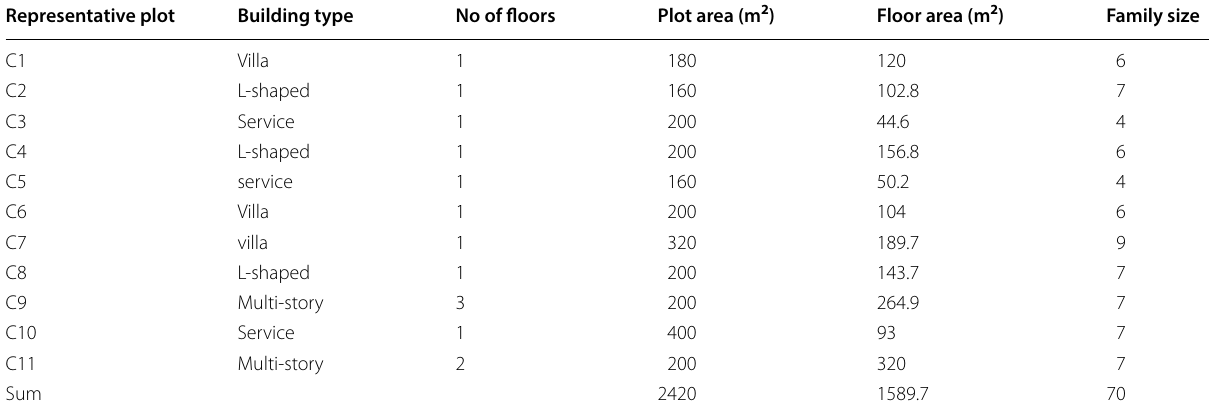
Table 1 Descriptions of sampled residences Representative